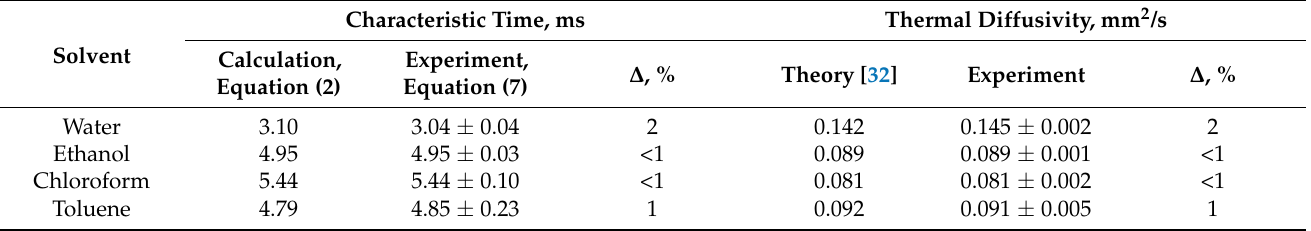
Table 3. Thermophysical parameters of reference samples ( n = 5, p = 0.95).